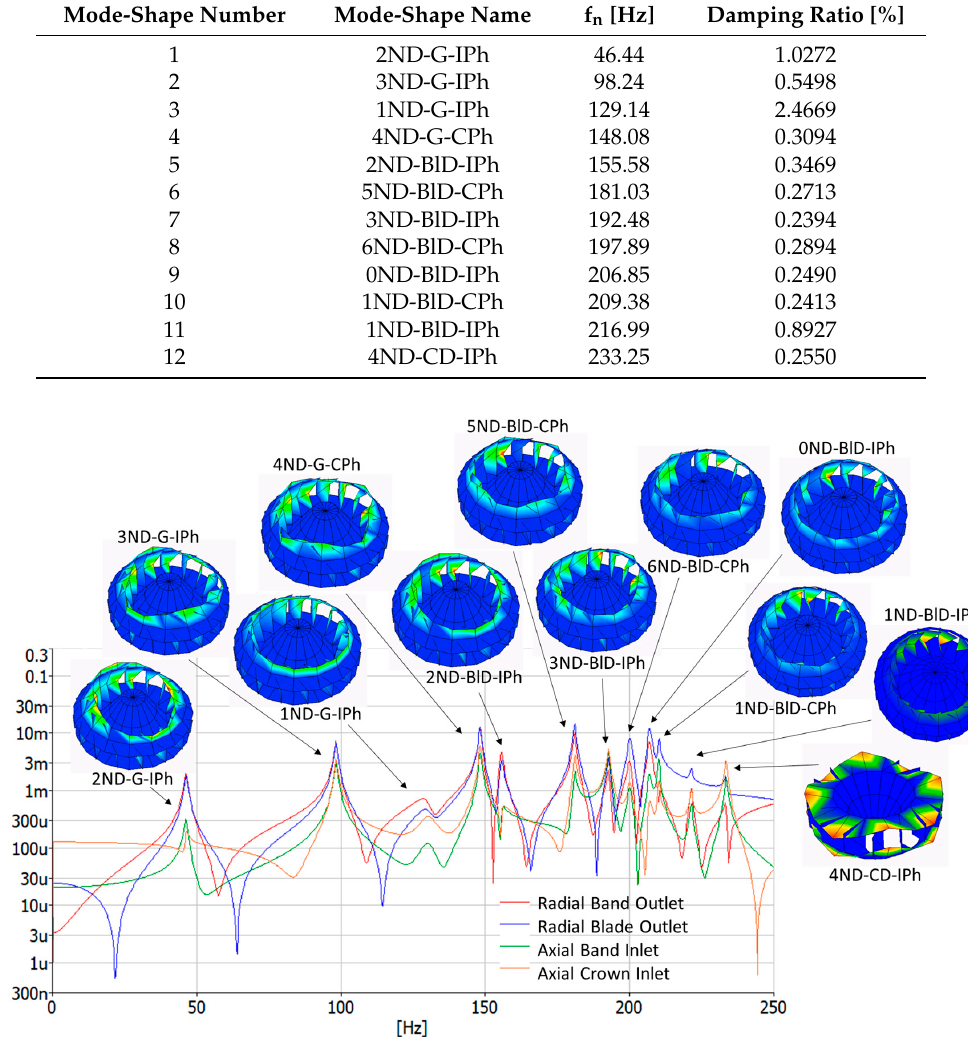
Figure 7. Frequency response function (FRF) in different points of the runner (0–250 Hz), as well as the operational deflection shape (ODS) of every runner mode shape associated with every natural frequency. Maximum displacement is colored red, and minimum displacement is colored blue. Videos of the mode shapes are found the Supplementary Materials section (S1 to